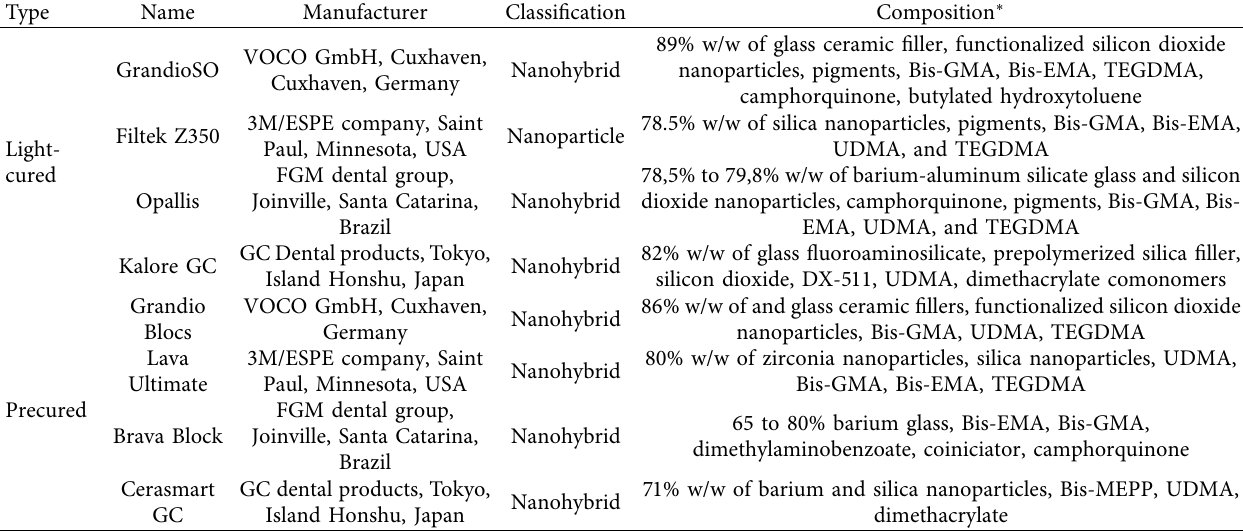
Table 1: Information about the composites